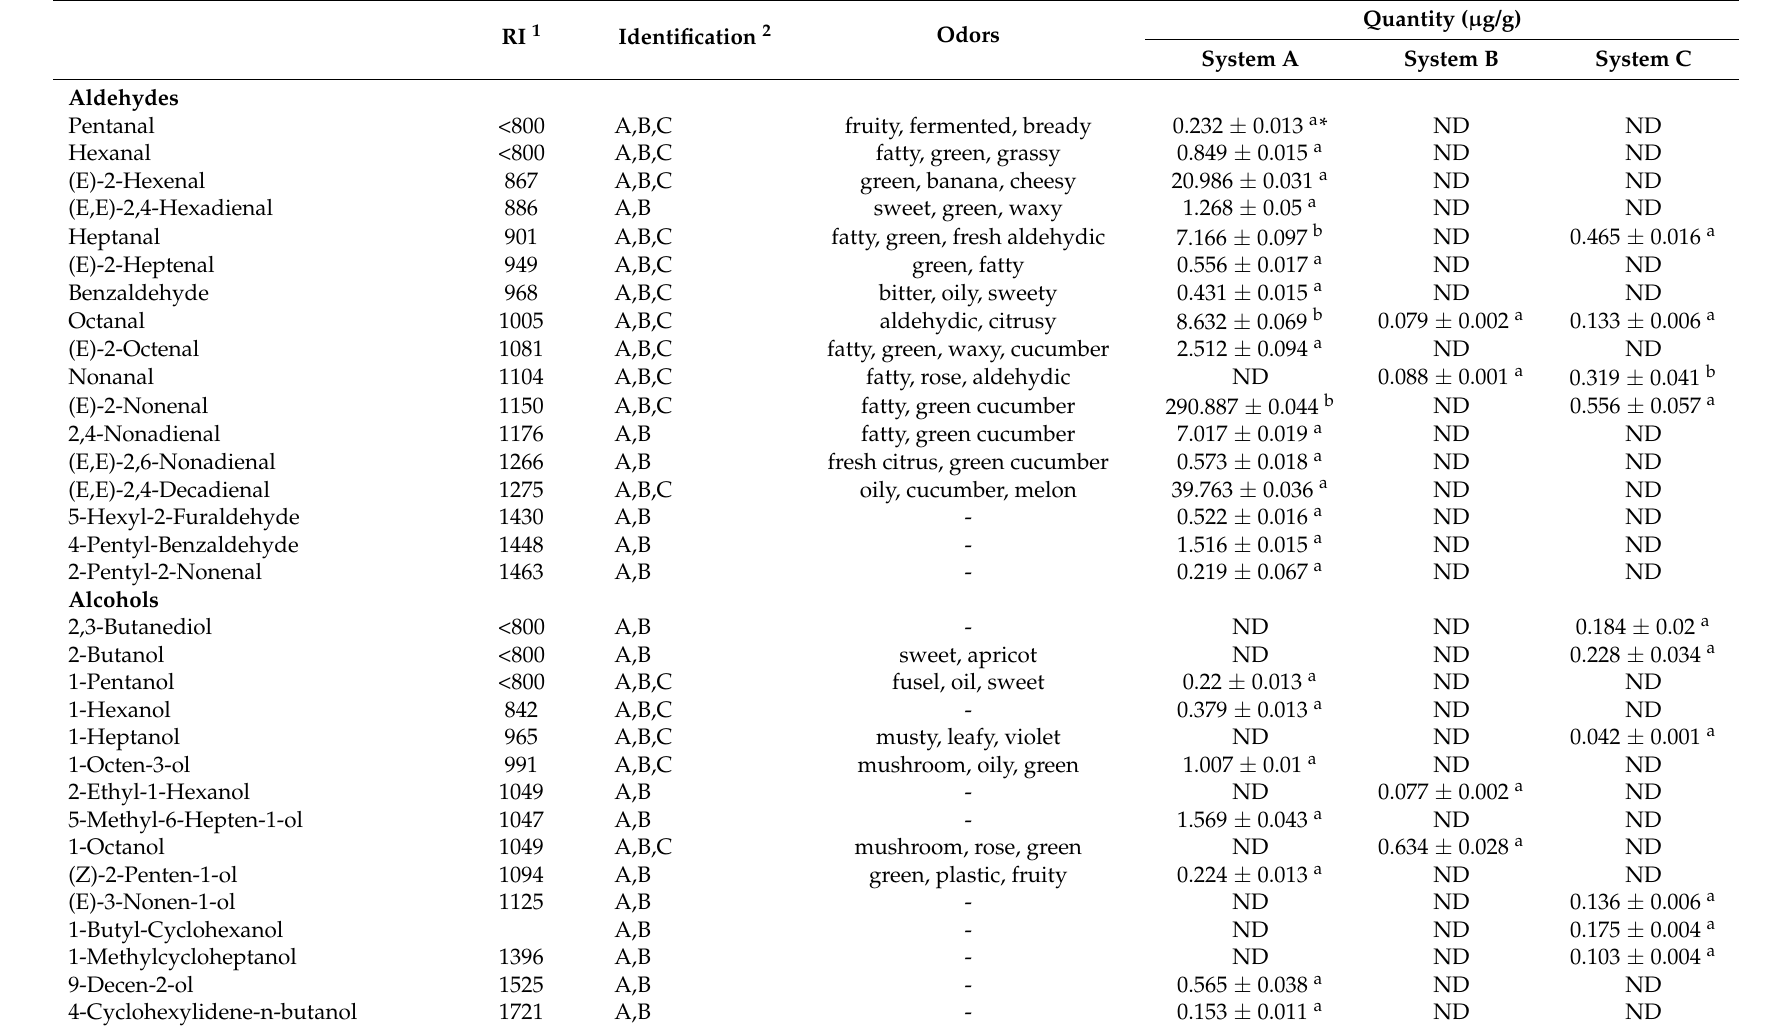
Table 2. Volatile compounds identified in model